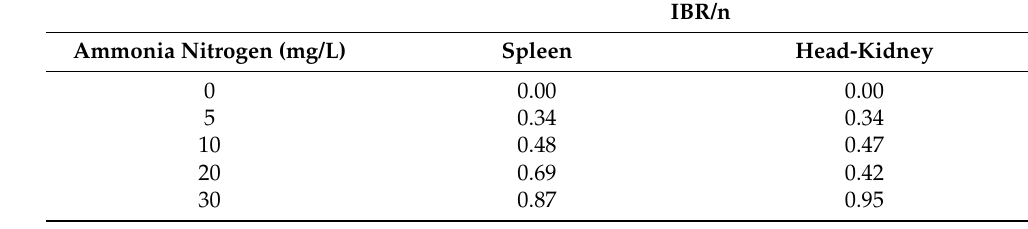
Table 2. Integrated biomarker response (IBR) indices of all measured parameters in the spleen and head-kidney of M. amblycephala to ammonia.